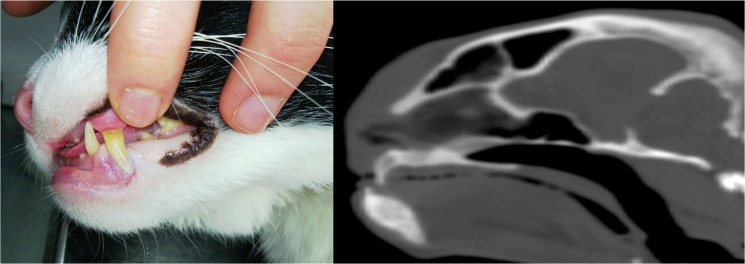
Example of prognathia inferior.This figure shows a cat with confirmed acromegaly demonstrating prognathia inferior (a), including a sagittal CT view of the cat’s head illustrating this conformational change further (b).